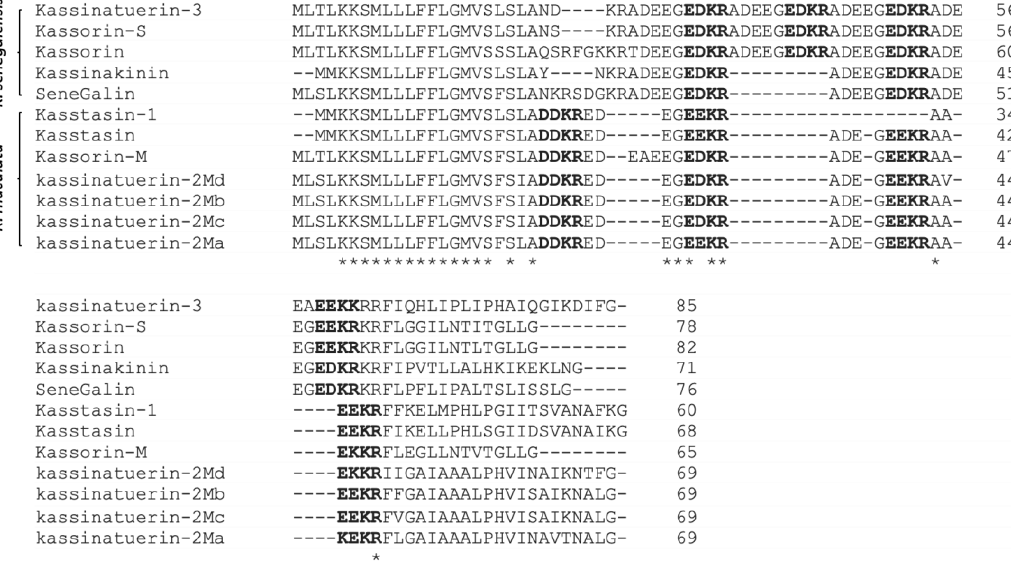
Figure 2. The alignment of the amino acid sequences of the biosynthetic precursors of bioactive peptides discovered in the skin secretions of K. senegalensis and K. maculata . Identical amino acids are indicated by asterisks (*). The acidic/basic tetrapeptide motif is indicated in bold typeface.